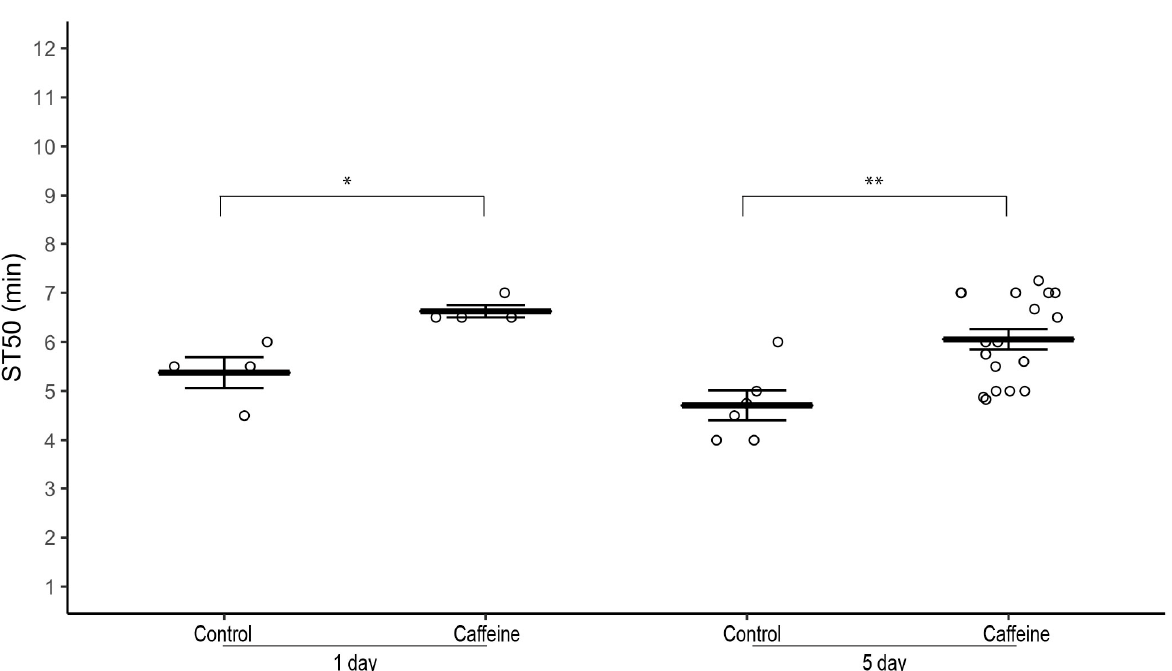
Figure 3. Effect of time course of caffeine supplementation on ethanol-induced sedation in w 1118 flies. Male w 1118 flies (1–3 day old) raised on 0.5 mg/mL caffeine-supplemented food for one day and five days have a significantly higher ST50 when exposed to 100% ethanol than control flies. Horizontal bars represent the mean ST50 ± standard error of 4–18 biological replicates. For each sedation assay 8–10 male flies were used (circles). * p < 0.05, ** p < 0.01; two-tailed independent samples t -test.